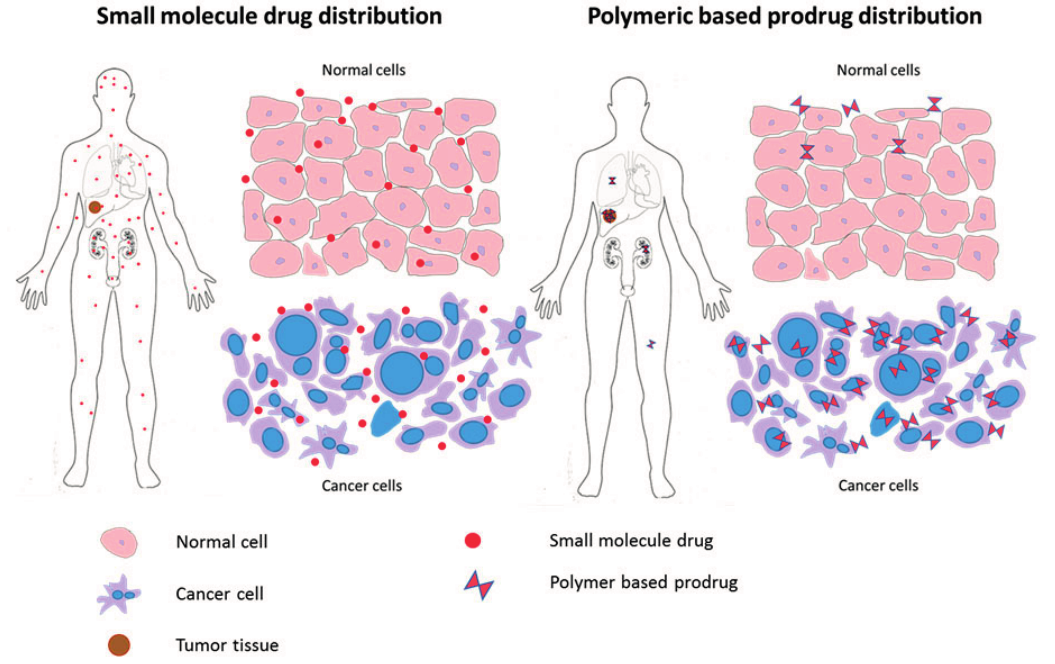
Figure 1. Small molecule drugs are distributed not only in tumor tissue, but are also widely distributed in all healthy tissues, resulting in adverse side effects ( left ); The polymeric macromolecular carrier is designed to spare healthy tissue from toxicity by preferentially accumulating within tumors, primarily by exploiting their disorganized tumor vasculature and poor lymphatic drainage through the enhanced permeation and retention (EPR) effect ( right